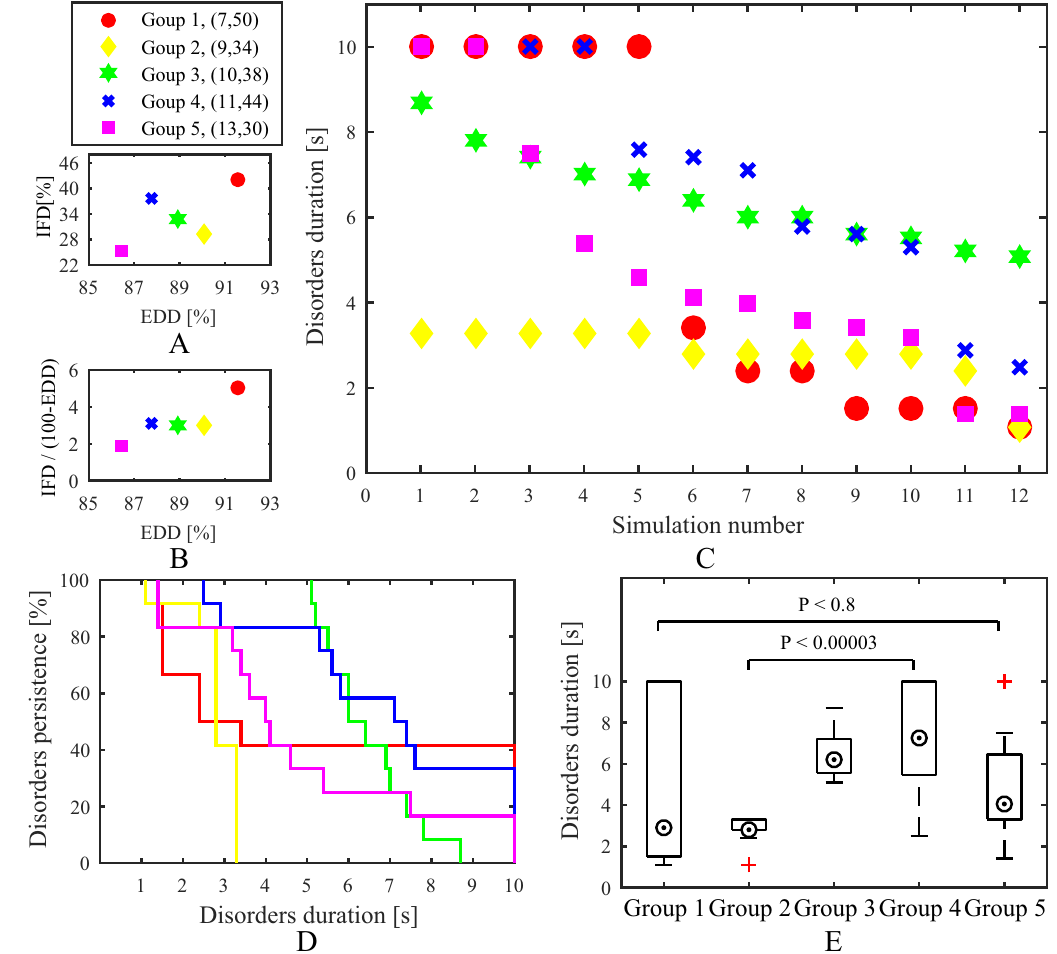
Fig 9. Simulation results of the dissociation-degree-controlled groups. (A) and (B) Distributions of average of intramural fibrosis degree and endo-epicardial dissociation degree for all simulations in each group. (C) A time distribution for all simulations. (D) Kaplan-Meier curves and (E) boxplots show effects of intramural fibrosis and endo-epicardial dissociation on stability. IFD is the intramural fibrosis degree and EDD is the endo-epicardial dissociation degree.